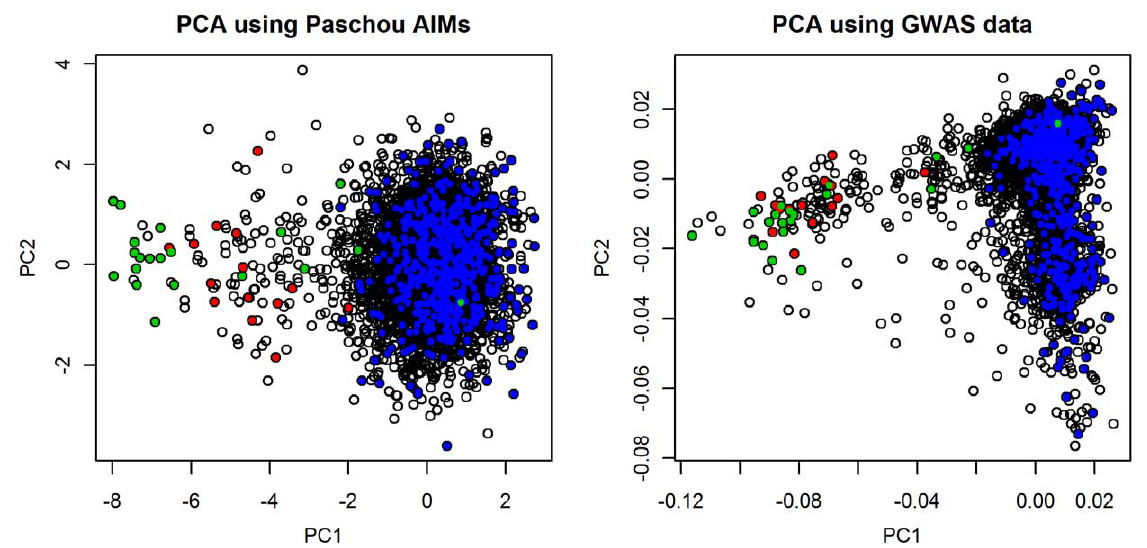
Figure 1. Comparison of Paschou and GWAS PCAs. Blue, green and red points represent individuals with the highest estimates of north- western, south-eastern and Ashkenazi Jewish ancestry respectively taken from MLE analysis with Price et al. AIMs panel.